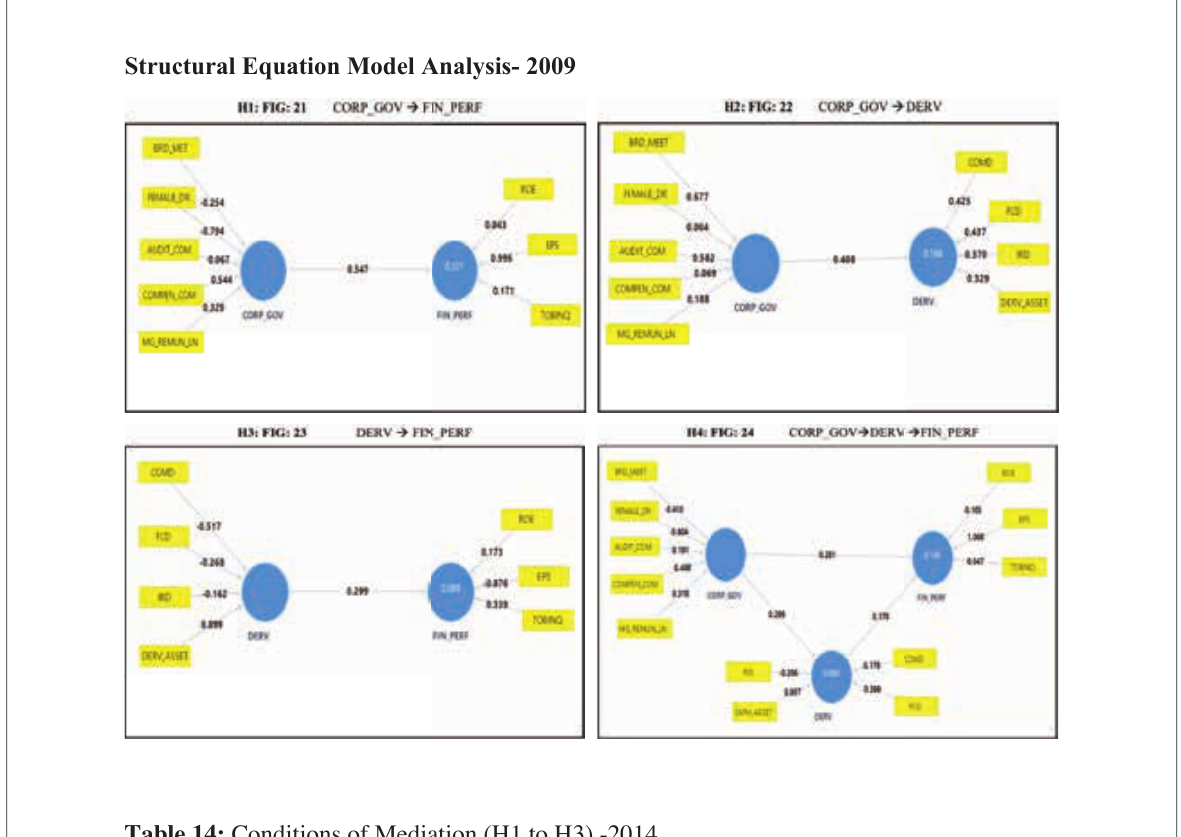
Table 14: Conditions of Mediation (H1 to H3)